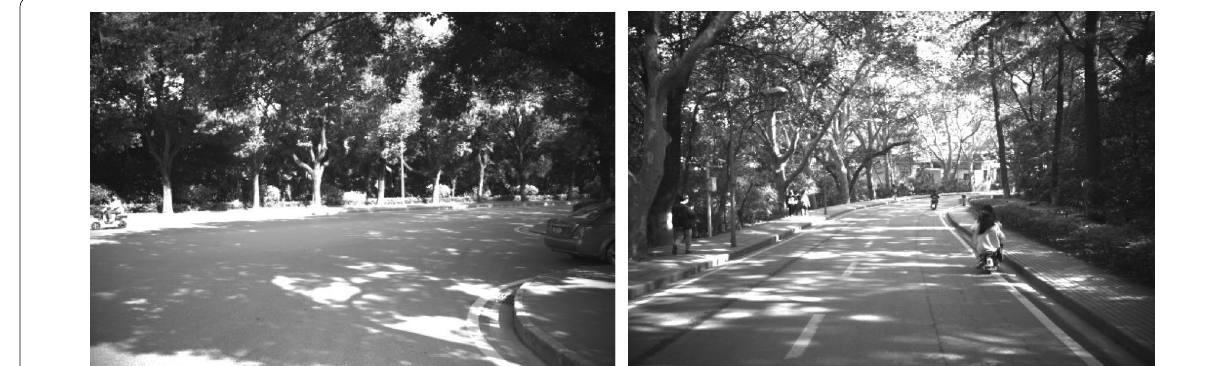
Fig. 3 Some typical scenarios in the experiments